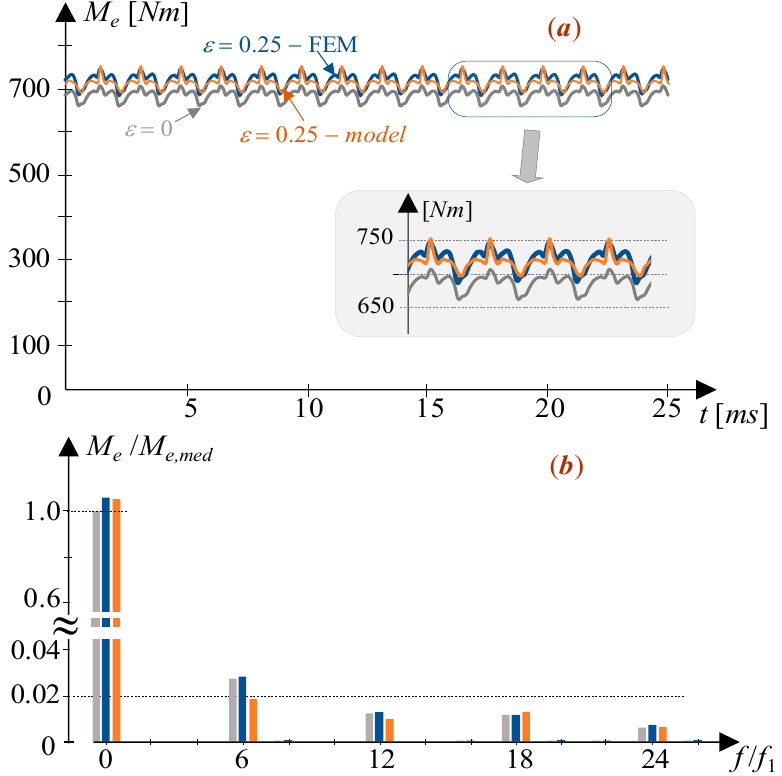
Figure 13. Motor electromagnetic torque. ( a ) Time waveform; ( b ) frequency spectrum. FEM analysis (blue and gray line) and model results (brown line).